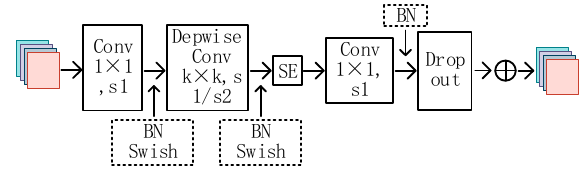
Figure 4. MBConv Module Structure.